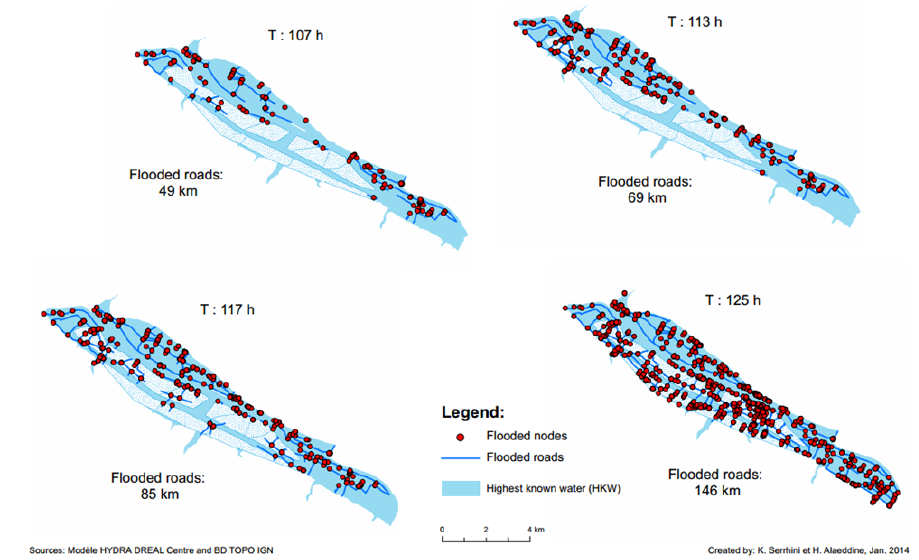
Figure 14. Dynamics of the hazard on the Gien valley’s road network.